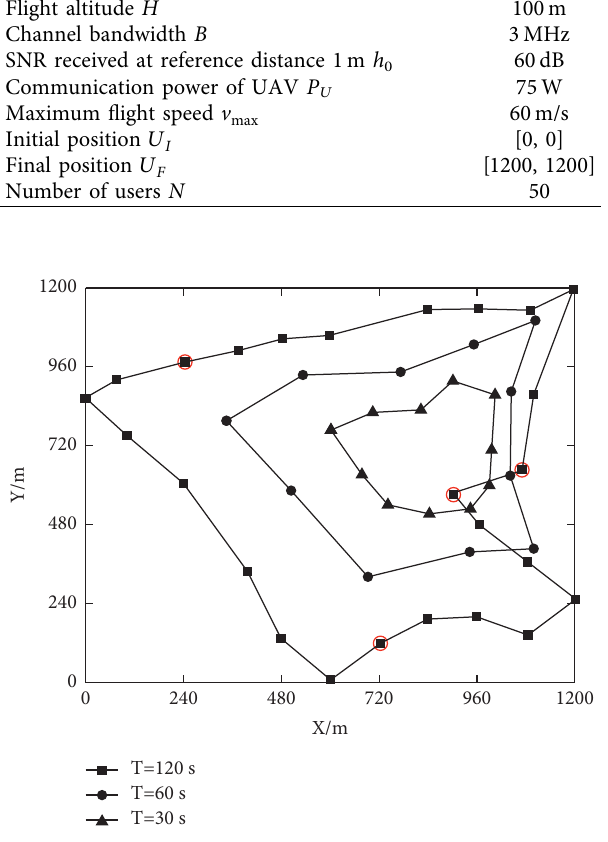
Figure 3: The map of UAV